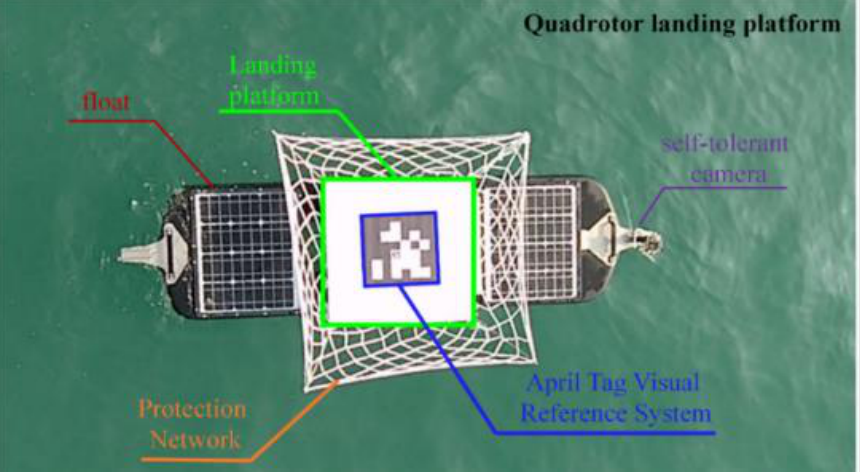
Figure 11. Quadrotor landing platform.